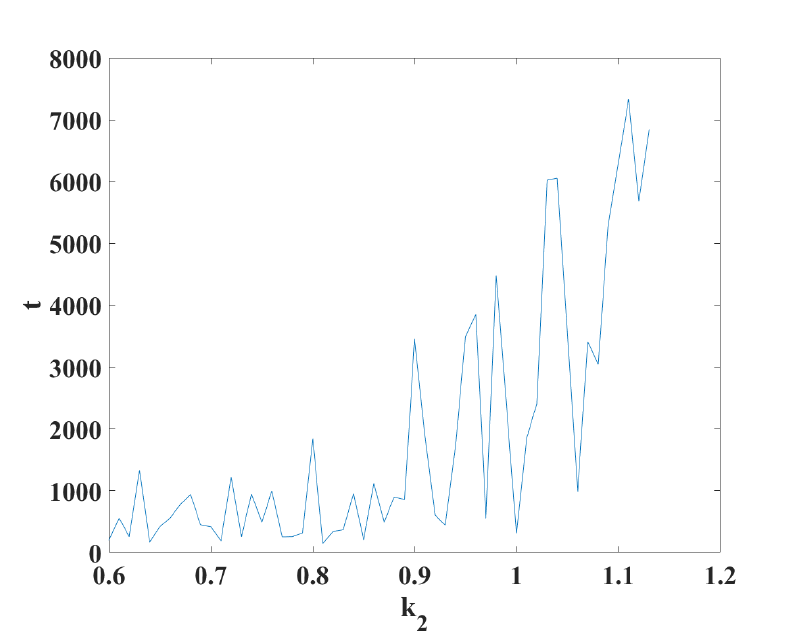
Figure 7. Times of particle settling for a fixed initial condition with respect to the y diffusion parameter.